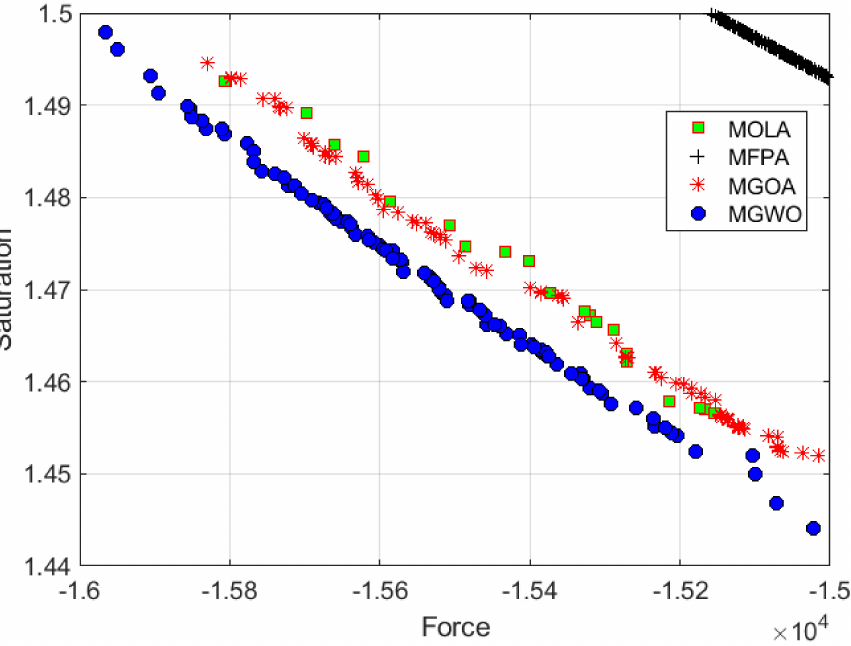
Figure 10. Obtained Pareto fronts of the developed MGWO, MFPA, MOLA, and MGOA for TLSM design under third case.